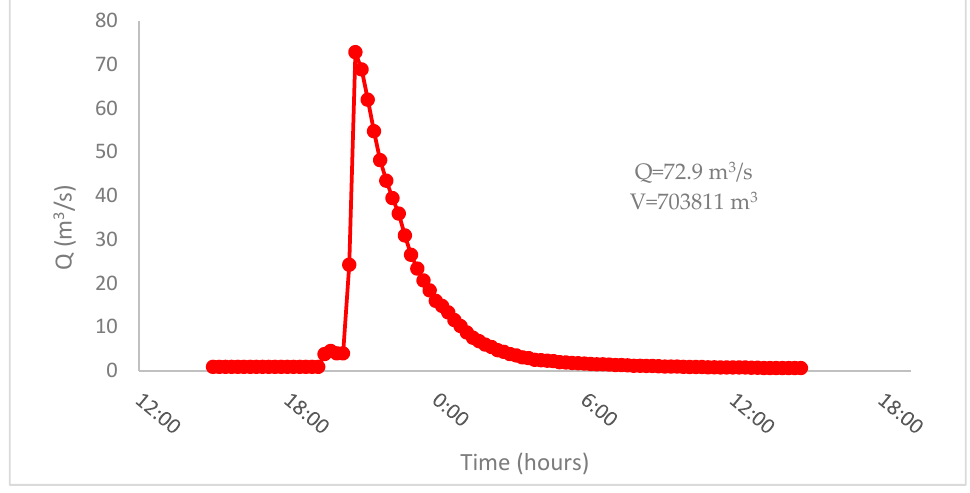
Figure 4. Monthly empirical average values computed for α . According to the procedure described in Section 2.1, ordinary least-squares regression through the origin (RTO) without constant term was applied to ( Q , V ) pairs, with month assignments arranged